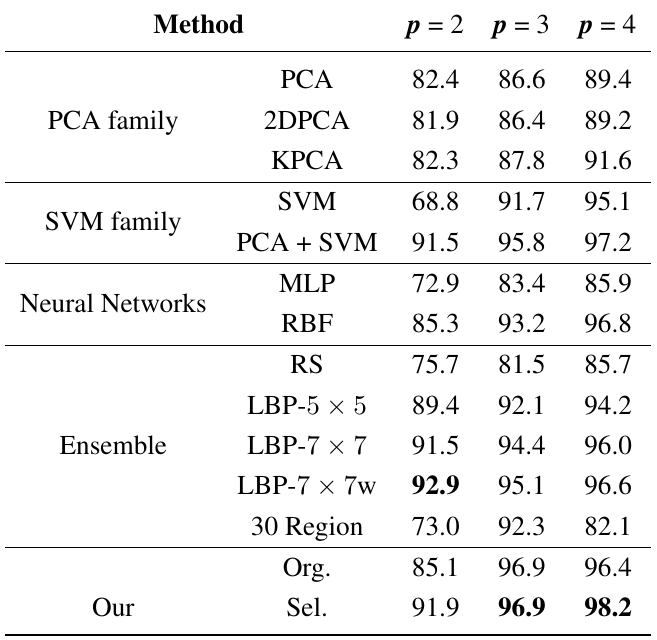
Table 3. Evaluation of the FERET-1 database. RPF, radial basis function; LBP, local binary pattern.